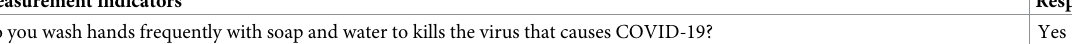
Table 3. Practice of people on COVID– 19 prevention strategies in Benishangul Gumuz Region, Assosa, Ethiopia, 2020. Measurement